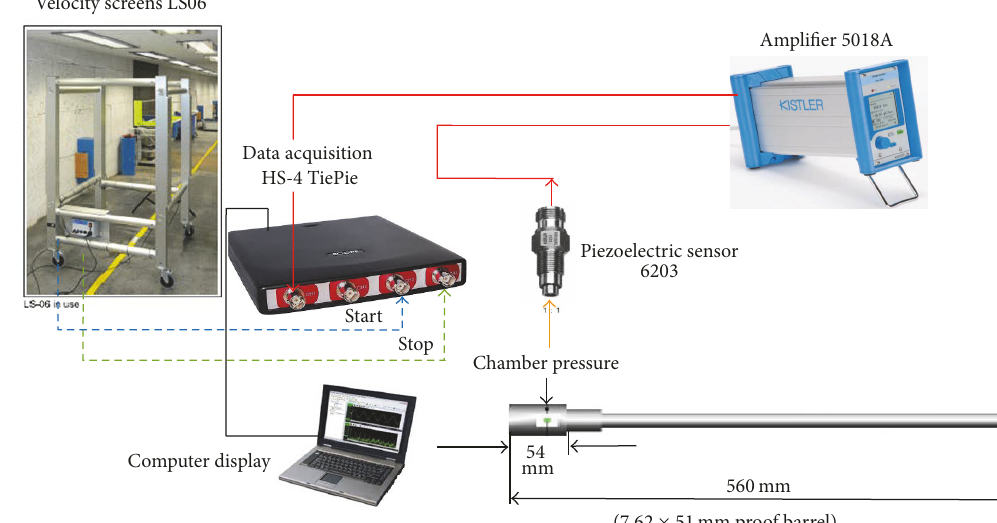
Figure 7: Schematic of chamber pressure measurement mechanism.